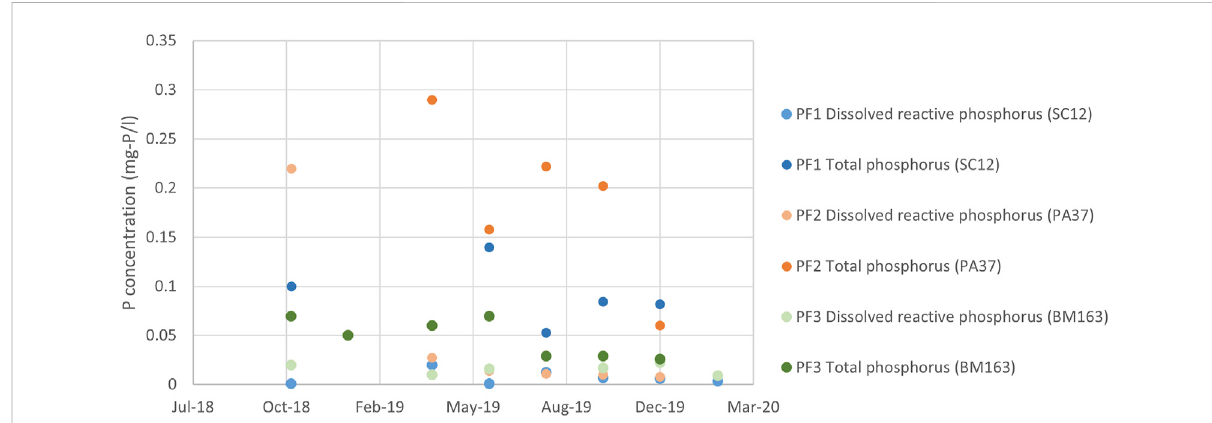
FIGURE 11 Timeseriesofphreaticwaterqualityfortotalphosphorusanddissolvedreactivephosphorusselectedmonitoringpointsrepresentativeofgood quality fen habitat.